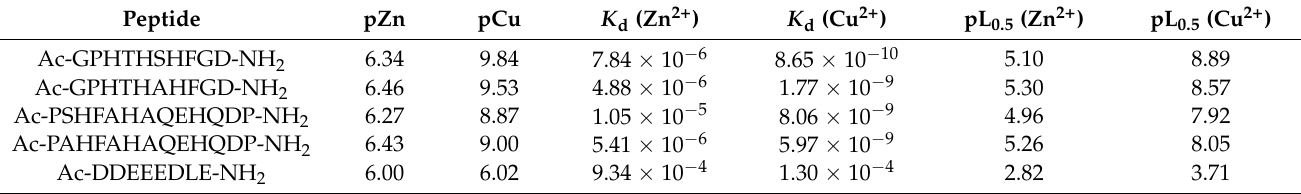
Table 3. Calculated dissociation constants ( K d ), pM and pL 0.5 values for Zn 2+ and Cu 2+ complexes with the investigated peptides at pH 7.4.